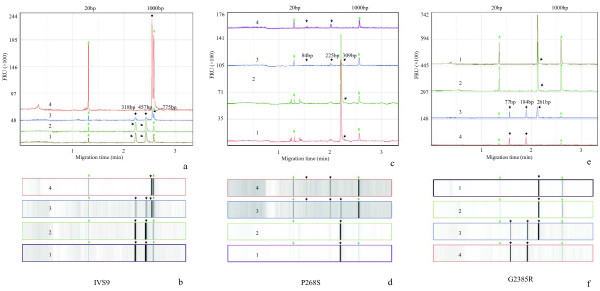
Capillary electrophoresis (CE) results of restriction fragments of 3 variants. a, c, e and b, d, f are the electropherograms and gel-views of IVS9, P268S, and G2385R after restriction digestion, respectively. The green arrows indicate markers (20 bp, 1000 bp) and black arrows indicate the restriction fragments. Restriction fragment sizes are shown in the Table 1: No mutation (wild-type/negative control), 2: Negative results in the control group, 3: Positive results (heterozygote) in the case group, 4: Homozygous mutation (homozygote/positive control). Because the signals are too strong for IVS9-4, P268S-1, P268S-2, G2385R-1, and G2385-2, 10 times markers are used to enhance the signal.